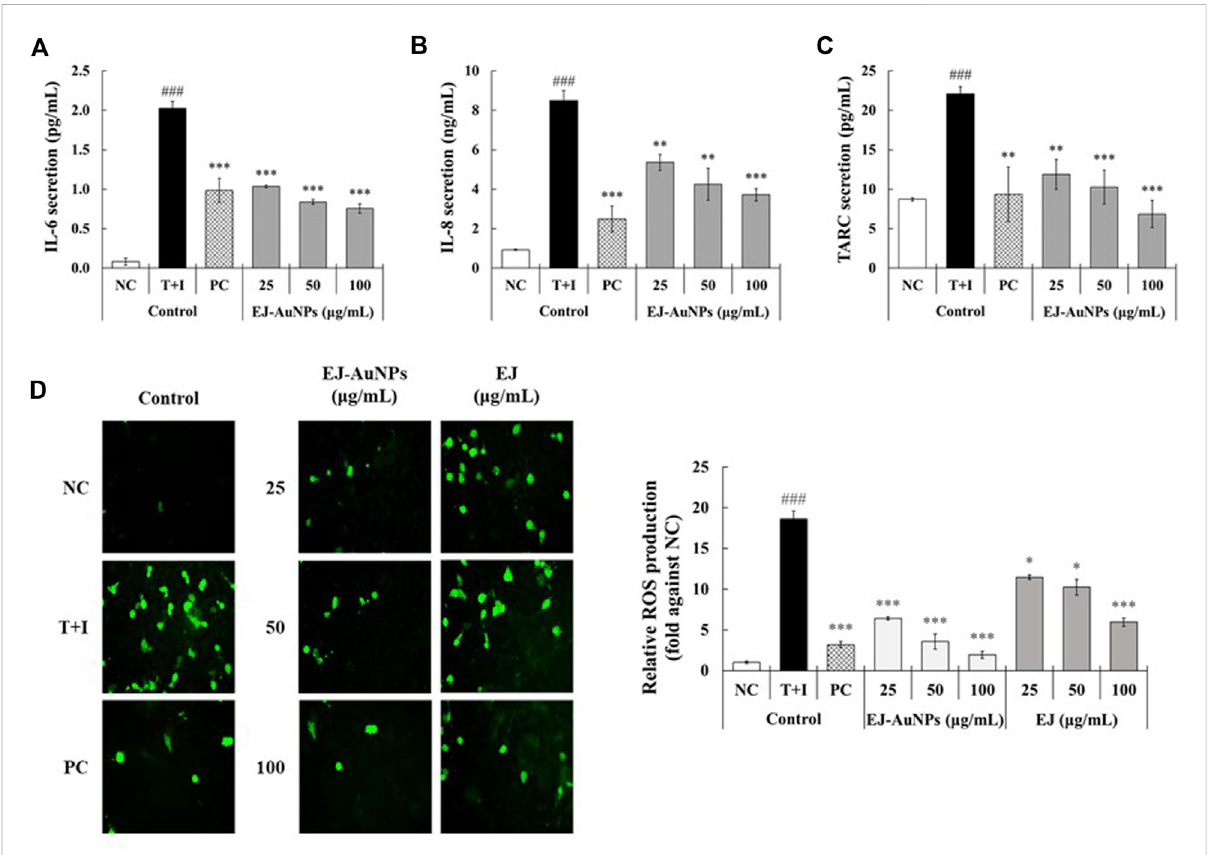
FIGURE 8 Effect of EJ-AuNPs on the secretion of pro-in fl ammatory cytokines, including (A) IL-6, (B) IL-8, and (C) TARC/CCL17, and production of intracellular (D) reactive oxygen species (ROS) in tumor necrosis factor-alpha and interferon-gamma (TNF- α and IFN- γ ; T+I)-treated HaCaT keratinocytes. NC, negative control treated with medium alone; T+I, in fl ammation-induced control treated with T+I alone; PC, positive control treated with dexamethasone (20 μ g/ml) followed by T+I stimulation. EJ-AuNPs, sample groups treated with EJ-AuNPs followed by T+I stimulation.Thecrosshatchmarksindicatethesigni fi cantdifferencesbetweenNCandT+I,andasterisksindicatethesigni fi cantdifferencesbetween T+I and each group. * p < 0.05; ** p < 0.01; *** and ### , p <